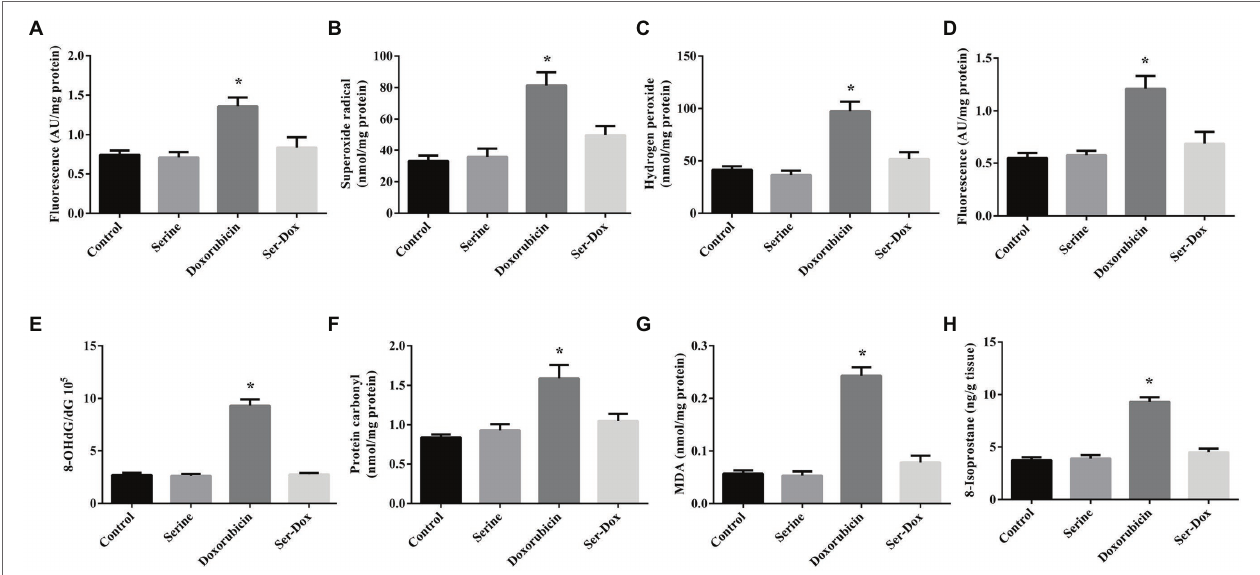
FIGURE 1 | Oxidation product contents in the skeletal muscles of mice. ROS content (A) , superoxide radical (B) , and hydrogen peroxide (C) contents in the skeletal muscles; ROS content in mitochondria (D) . 8-OHdG (E) , protein carbonyl (F) , MDA (G) , and 8-isoprostane (H) contents in the skeletal muscles. Values are expressed as LSmean plus pooled SEM, n = 8. *Mean values were significantly different among groups ( p < 0.05). ROS, reactive oxygen species; 8-OHdG, 8-hydroxy-2 ' -deoxyguanosine; and MDA,